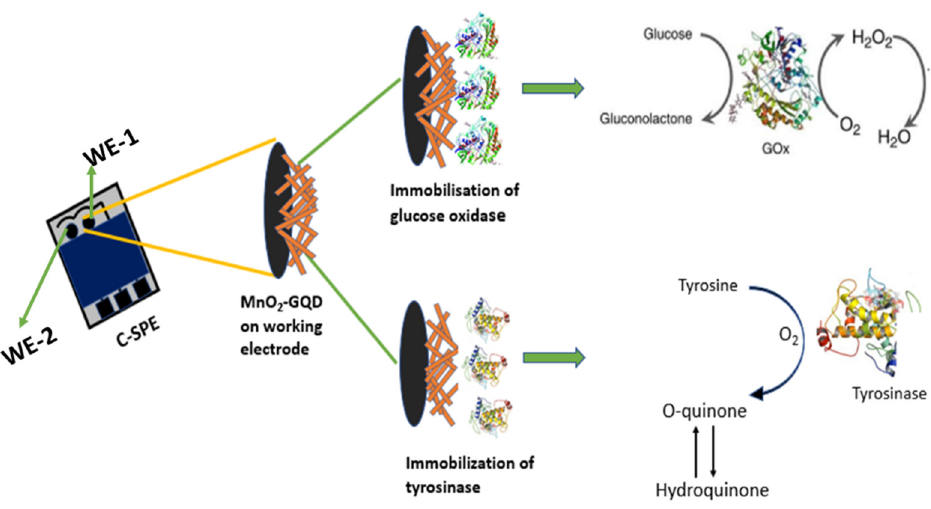
Figure 1. Steps involved in the fabrication of microfluidic multiplexed paper-based sensing strip.